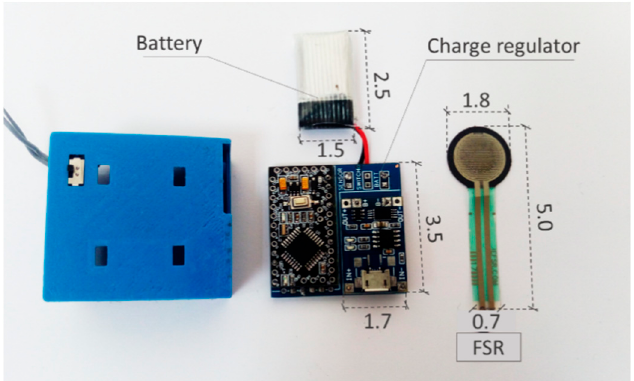
Figure 19. Charge regulator and battery (low capacity, 150 mAh) integrated into the sensing prototype developed by Vanegas et al. [254], slightly modified. The sensor used in that prototype (a force-sensitive resistor) is included separately for size comparison. Units: cm.